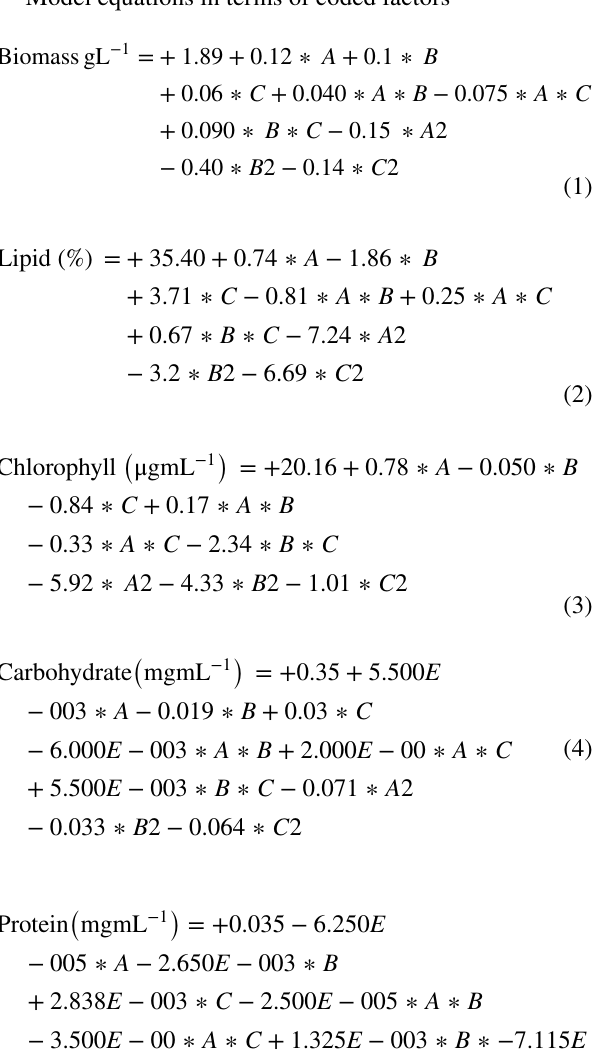
Table 3 Independent factors influence on the response variables